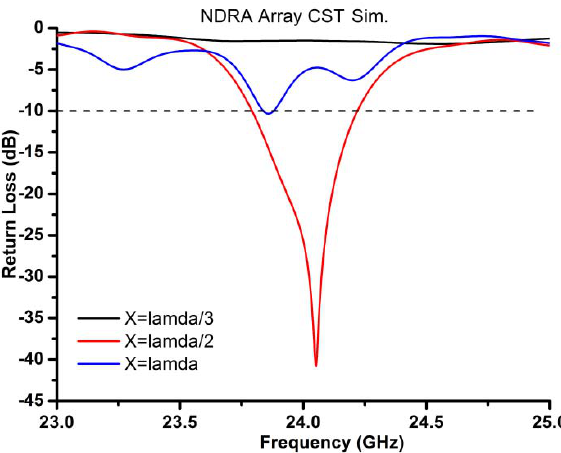
Figure 7: Return Loss for various antenna spacing (X) of NDRA